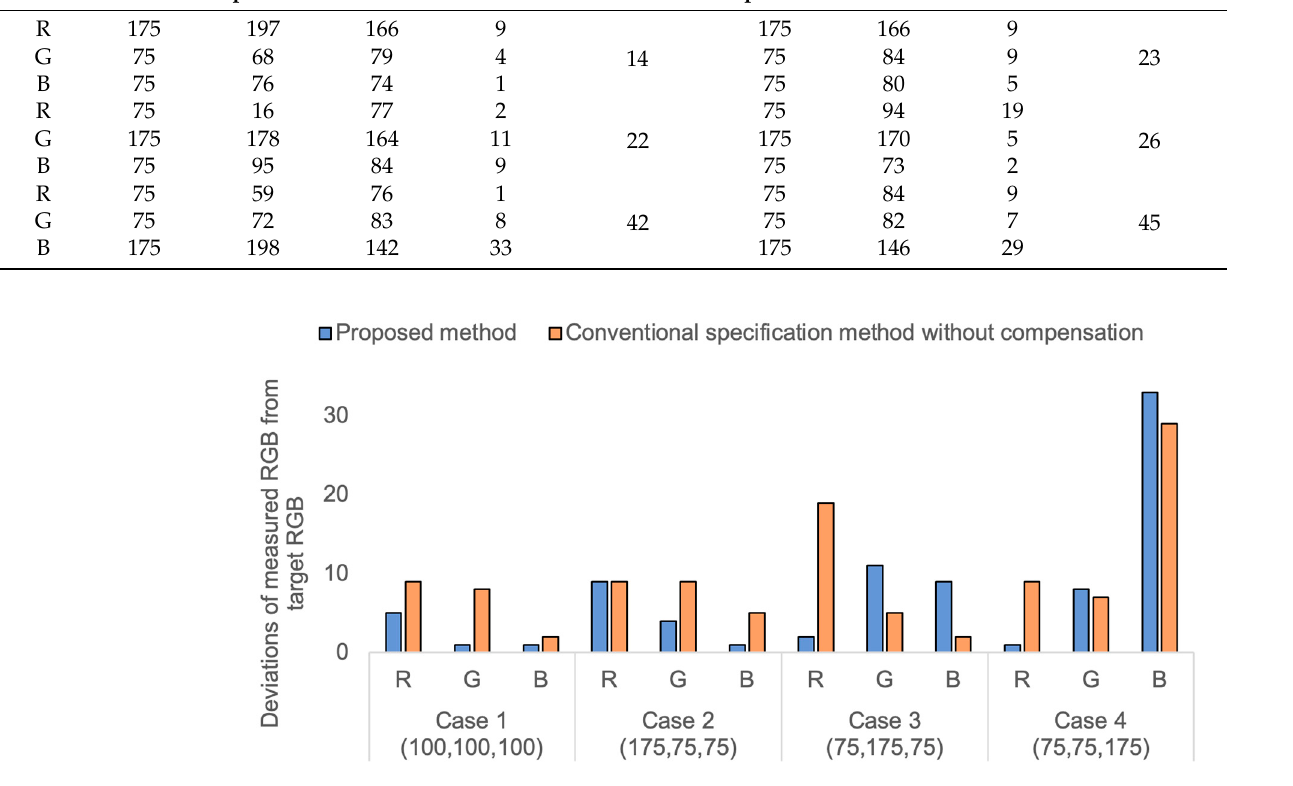
Figure 5. Deviations of measured RGB values from target RGB values when using the proposed method versus the conventional specification method without